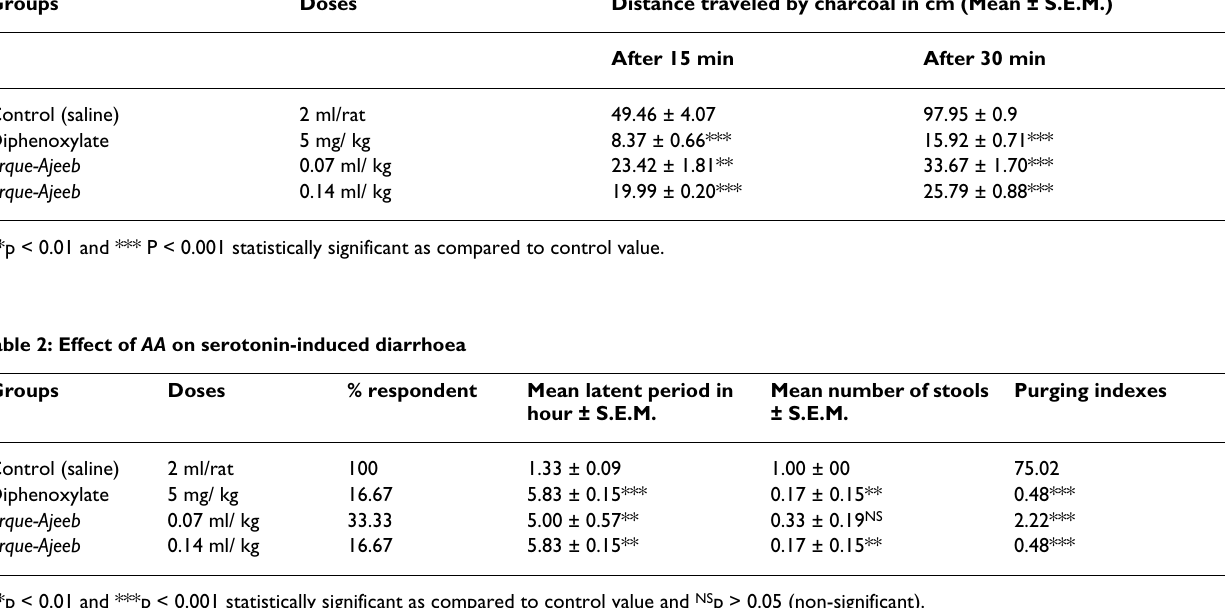
Table 1: Effect of AA on charcoal-induced gut transit changes Groups Doses Distance traveled by charcoal in cm (Mean ± S.E.M.)